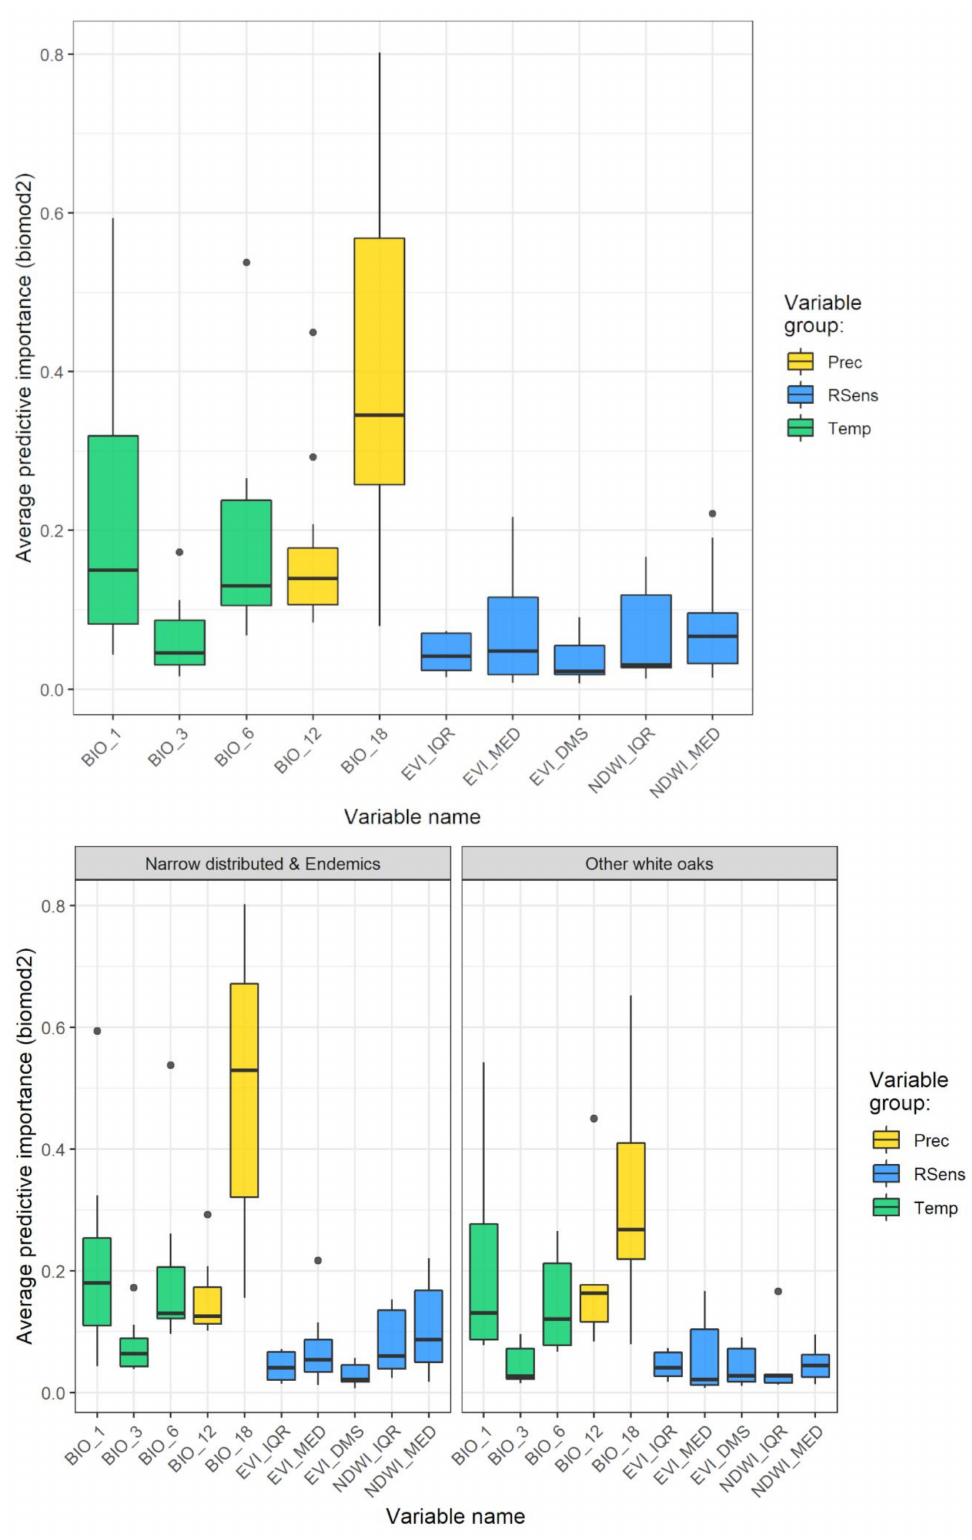
Figure A2. Variables contributions; all species (above); NDE and other oaks